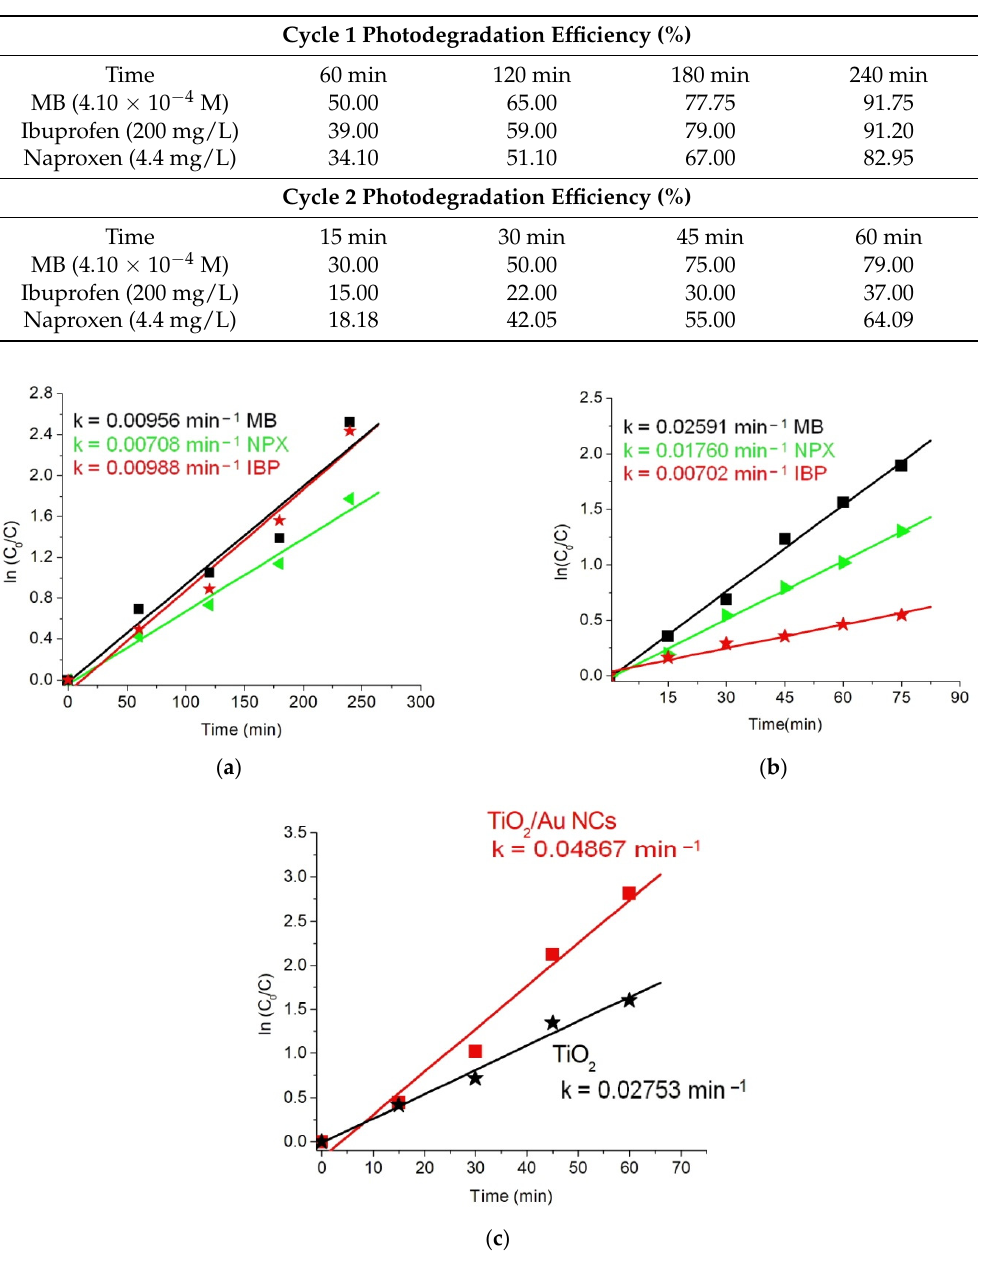
Figure 9. Pseudo-first order kinetics of (MB) dye, ibuprofen, and naproxen for ( a ) cycle 1 and ( b ) cycle 2 under direct sunlight exposure; and ( c ) MB under controlled visible light irradiation. Table 1. Solar-assisted photodegradation efficiencies of {001}-TiO 2 /Au NCs for cycles 1 and 2.